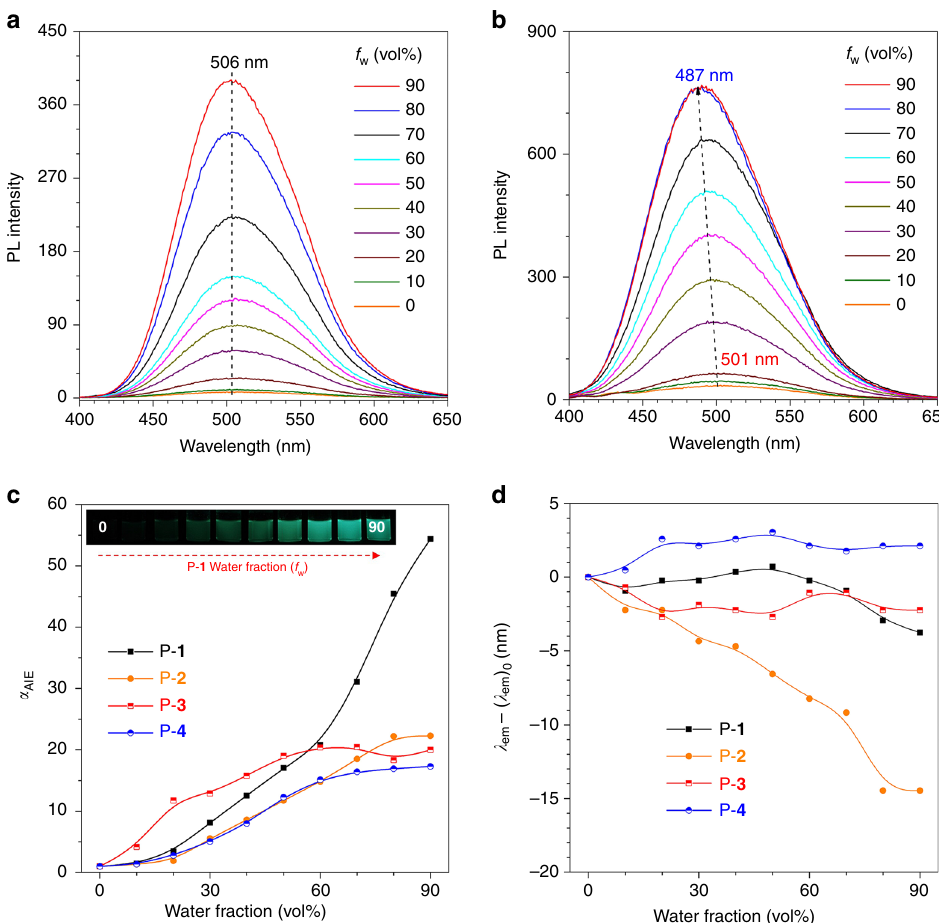
= 0%. Inset: photographs of P- 1 in THF/water mixtures with different f w